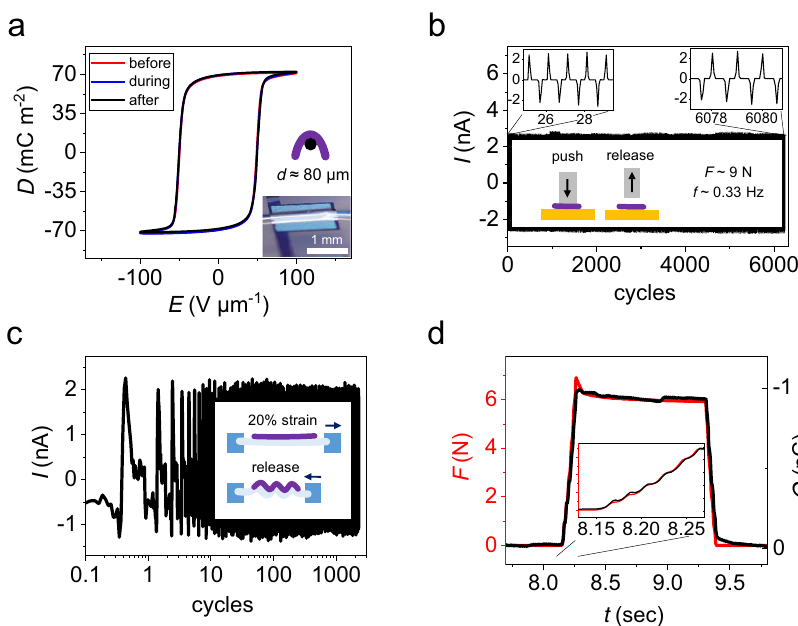
Fig. 4 Stability test and response time measurements of UFPTs. a D(E) -hysteresis curve of an UFPT before, during and after bending over an 80- µ m-thick gold wire. Durability testing under ( b ) transversal-load and ( c ) longitudinal-strain conditions. b Current response when a transducer mounted on a glass carrier is subjected to repeated transversal compression and release via a stamp over a period of more than 5 h (>6000 cycles). c Current response upon longitudinal strain cycling over more than 1000 periods. The inset schematically illustrates the longitudinal tensile test procedure. First, the UFPT was mounted on a 20% pre-strained rubber carrier, which was clamped at both ends. Then, by periodically relaxing and stretching the carrier (light blue) over an interval of 0 – 20% strain, the transducer (purple) was contracted or retracted, respectively. d Time dependence of the charge response of the UFPT for a trapezoidal transversal load with a top force level of 6 N and a rise time of « 20 ms N − 1 . The charge response signal (black) precisely follows the force pro fi le